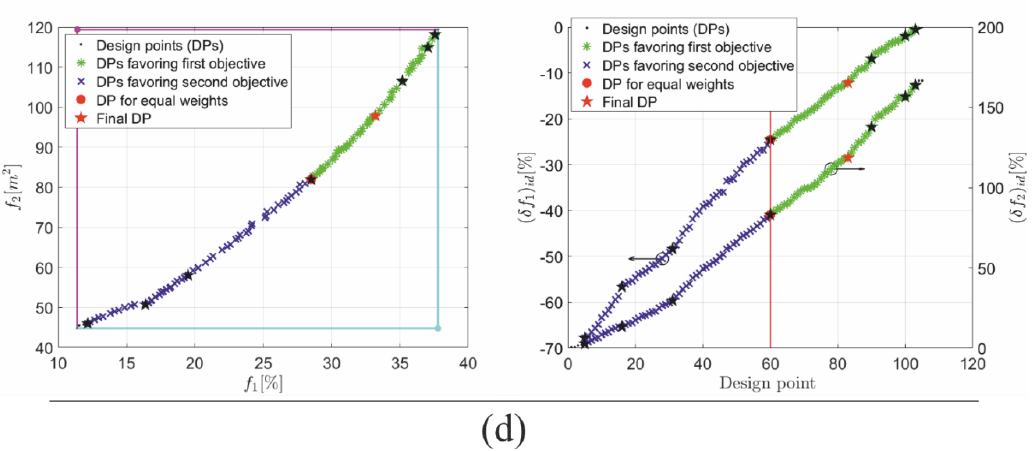
Figure 6. Graphs generated by the proposed decision-making tool: ( a )—Pareto front and double y-axis graph, ( b )—covering the decision-making preferences, ( c )—marking the proposed design points, ( d )—marking the final design point.